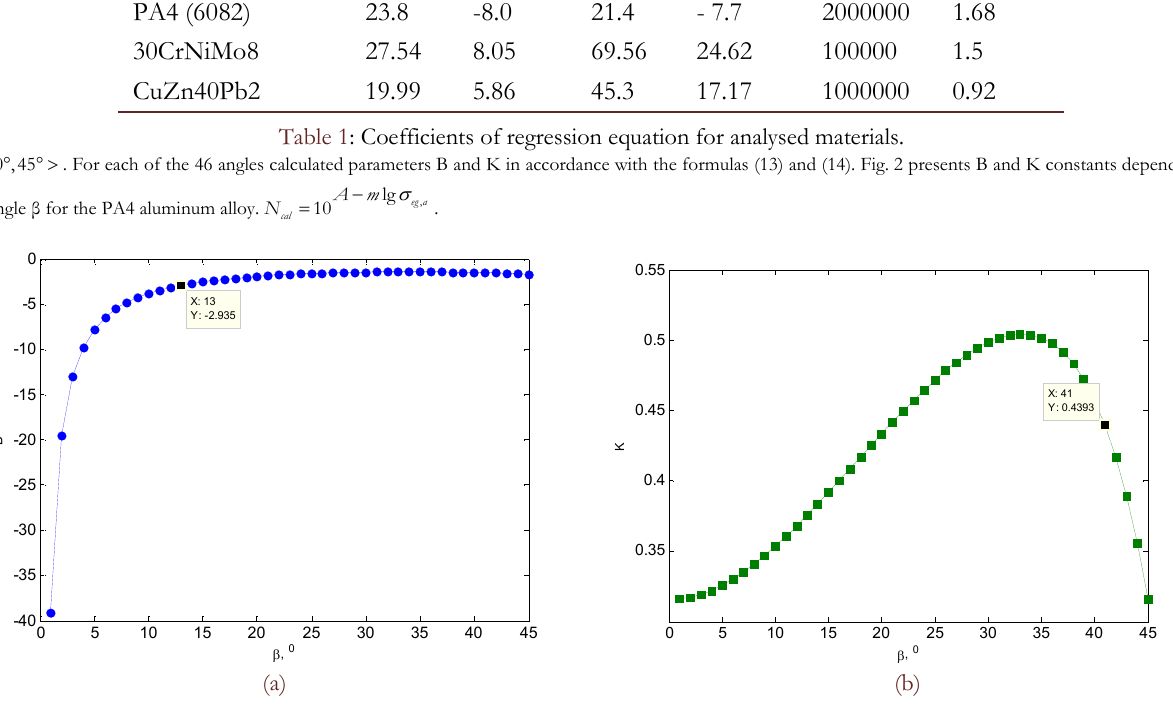
Figure 2: The dependence of the parameter a) B, b) K from the angle β for aluminum alloy 6082